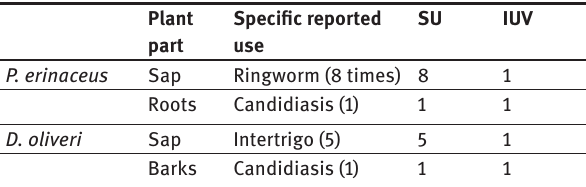
Table 3: SU and IUV as indicators of potential uses of the pre- selected plants.